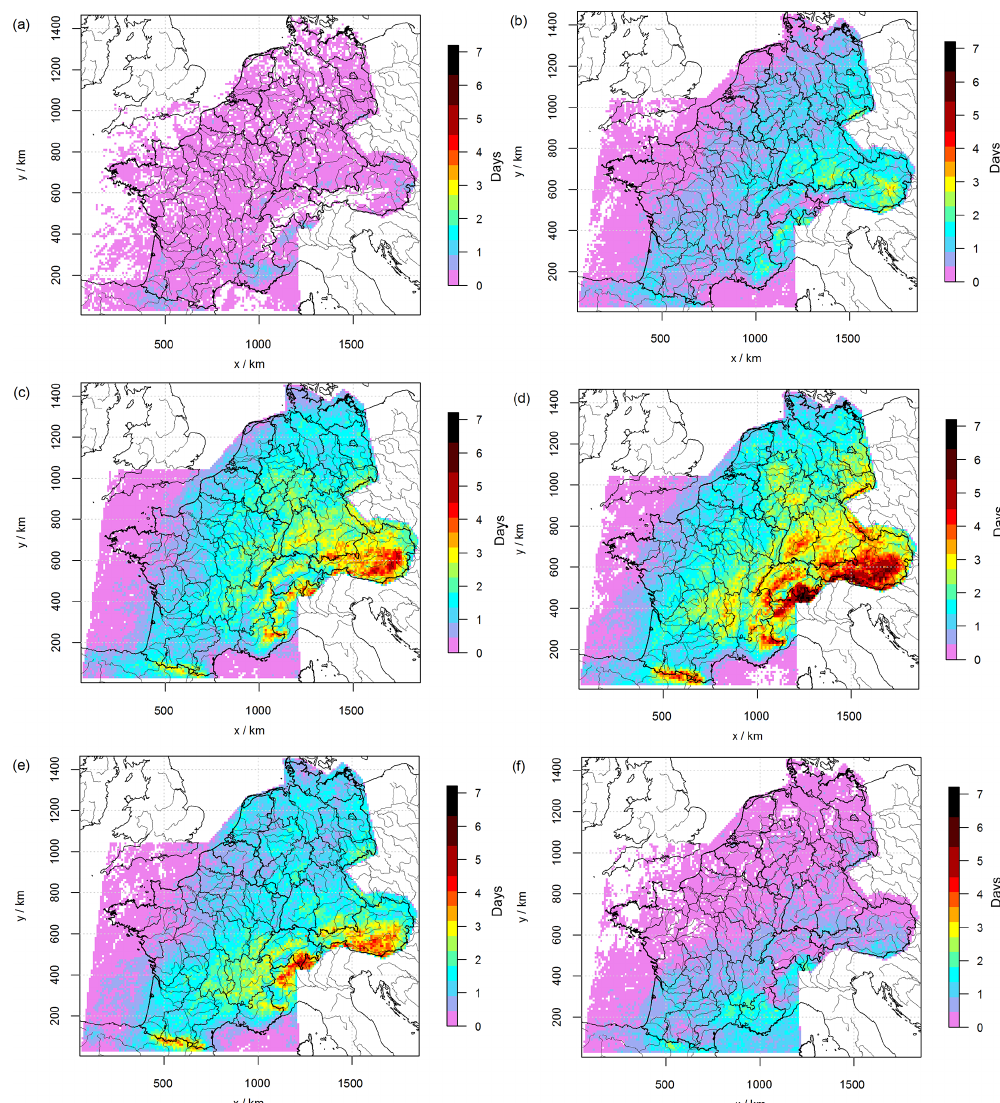
Figure 7. Mean number of thunderstorm days during the summer half-years 2001–2014 in April (a) , May (b) , June (c) , July (d) , August (e) , and September (f)